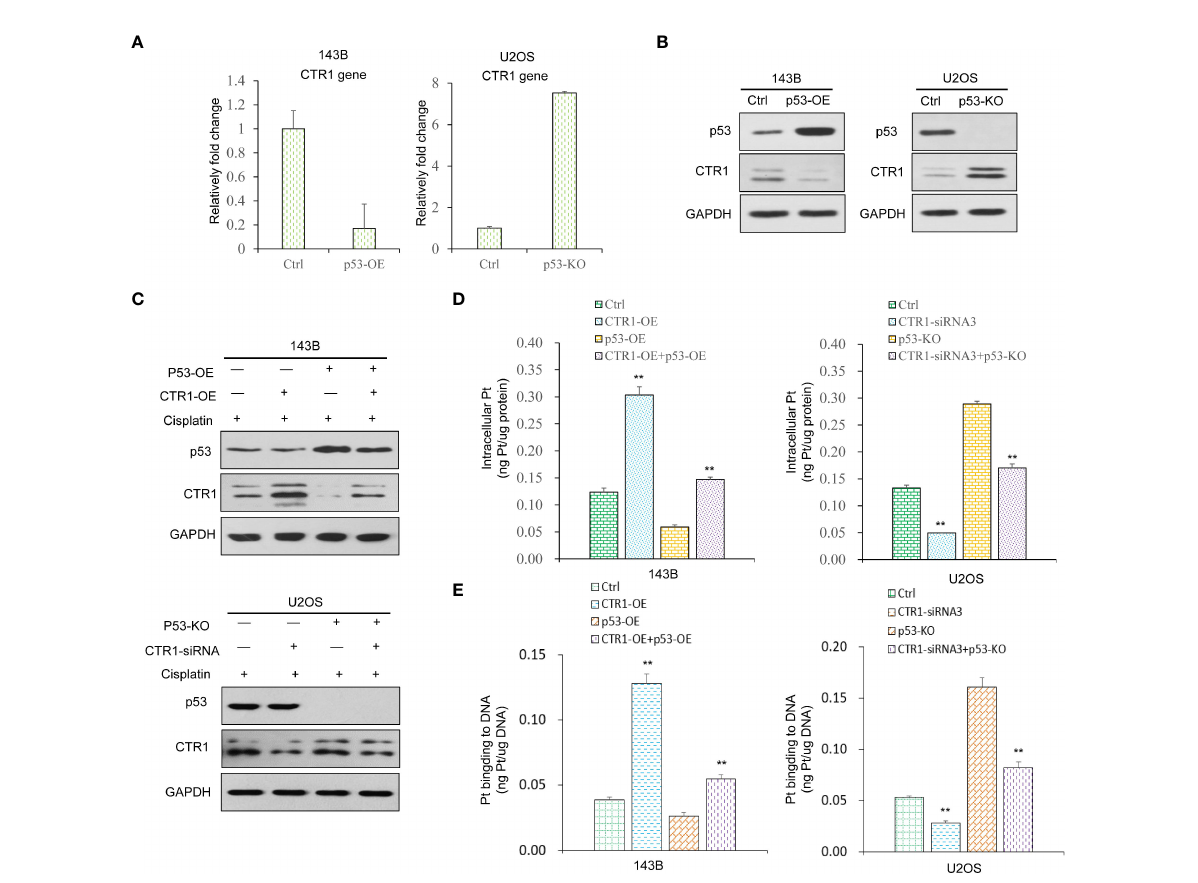
FIGURE 3 The function of p53 on CTR1 expression and cisplatin absorption in OS cells. (A) CTR1 mRNA expression was detected by RT-qPCR in p53 over- expression (p53-OE) 143B OS cell line and p53 knock-out (p53-KO) U2OS OS cell line. (B) CTR1 protein expression was detected by western blot in p53-OE 143B OS cell line and p53-KO U2OS OS cell lines. GAPDH was used as the internal control. (C) 143B cells overexpressed with the p53 gene and control cells were transfected with CTR1-OE plasmid upon cisplatin treatment. U2OS cells with p53 gene knock-out and control cells were transfected with CTR1-siRNA upon cisplatin treatment. The protein level of p53 and CTR1 was detected by western blot. GAPDH was used as the internal control. (D) Cisplatin accumulation (E) content of Pt ‐ DNA adducts in all groups (143B cells with p53-OE or CTR1-OE, U2OS cells with p53-KO or CTR1-siRNA) treated with cisplatin (10 m g/ml) for 24h was detected by ICP-MS. Data are representative of three independent experiments. Bars show mean ± SD. Ctrl, the control group;